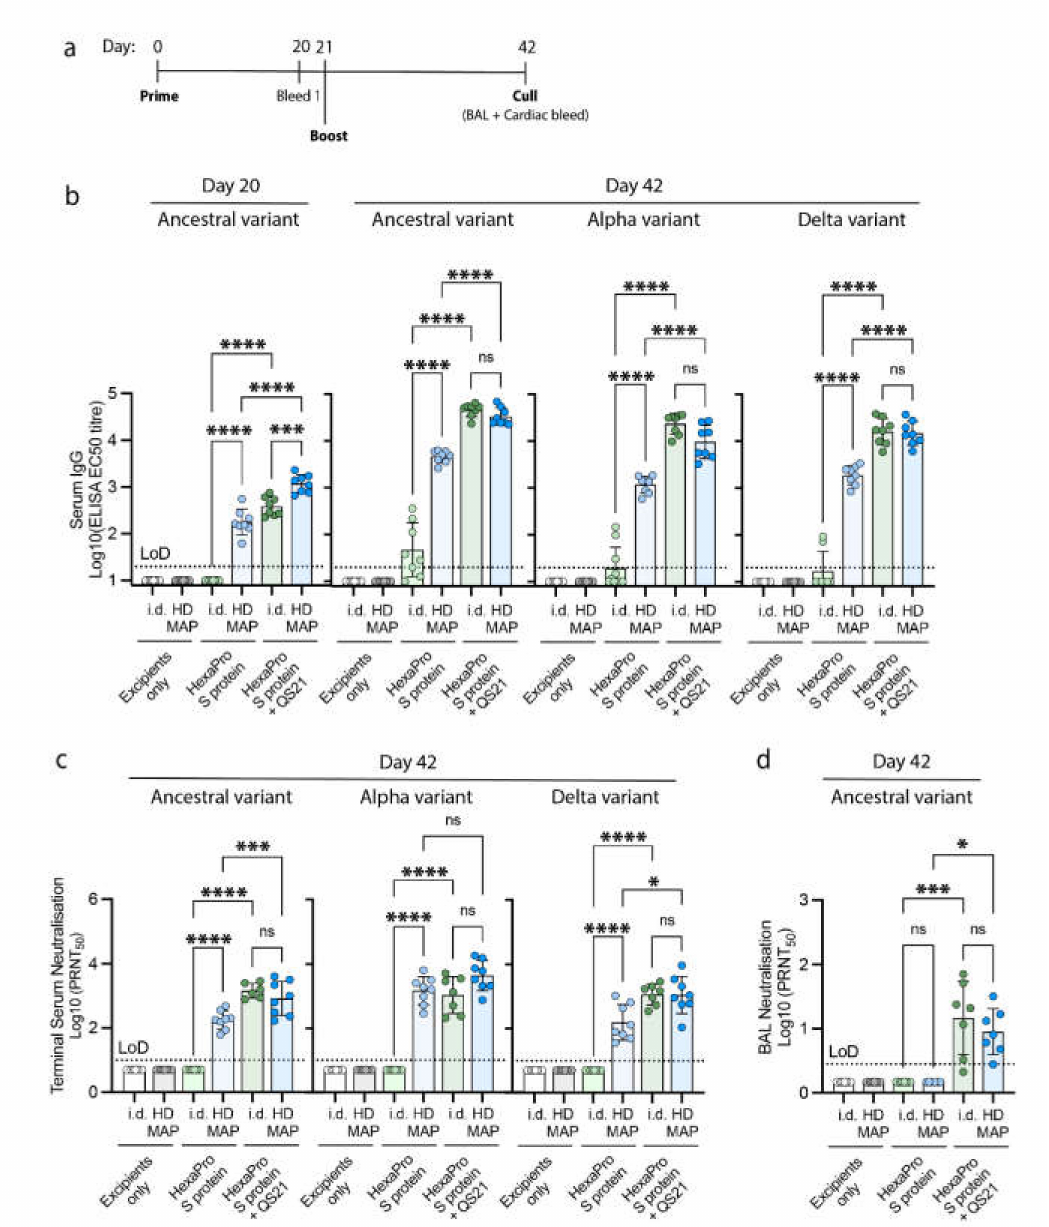
Figure 3. Immune responses in BALB/c mice following the vaccination with excipients (negative control), HexaPro S protein, and HexaPro S protein + QS-21 via intradermal injection (i.d.) or HD-MAP application ( n = 8, each), ( a ) vaccination schedule. Serum was collected after primary immunization and first boost (on day 20 and 42, respectively) and analyzed for ( b ) serum IgG antibody titers against HexaPro S protein and HexaPro S protein derived from Alpha and Delta variants by ELISA. Serum and bronchoalveolar lavage (BAL) collected on day 42 were analyzed for ( c ) serum virus neutralization by plaque reduction neutralization test (PRNT) against the parental SARS-CoV-2 isolate, an Alpha variant, and a Delta variant, and ( d ) BAL virus neutralization by PRNT against ancestral SARS-CoV-2 variant, respectively. Each point represents an individual biological replicate (mouse) performed on a single ELISA assay; bars represent the average antigen-specific IgG antibody titers (EC50); error bars represent the SD; the LoD line represents the assay limit of detection. Statistical analysis was performed using one-way ANOVA with Tukey’s multiple comparison post hoc test ((*) p < 0.05, (***) p < 0.001, (****) p < 0.0001 and non-significant